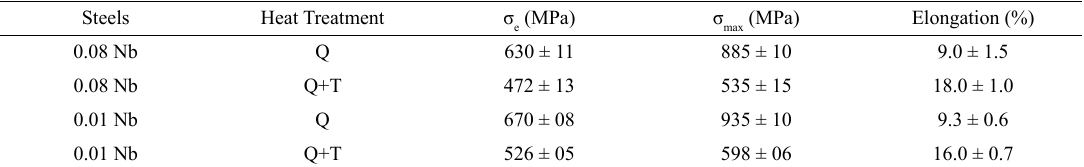
), tensile strength (σ ) and elongation of steels after quenching at 900 ºC (Q) and quenching at 900 ºC plus Table 3. Yield strength (σ e max tempering at 600 ºC (Q+T). Steels